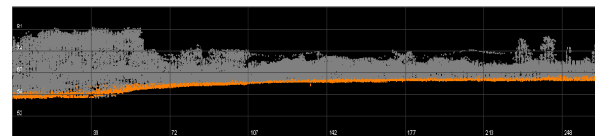
Figure 1. Cross-section view of ground and non-ground